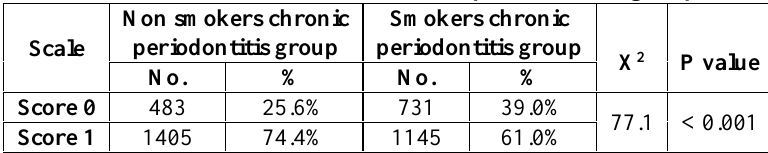
Table 2: Number and percentage (in sites) of bleeding on probing scores and Chi-square test